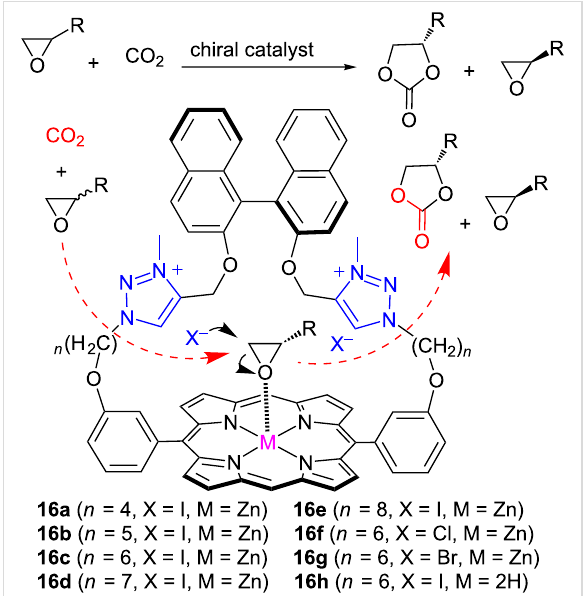
Figure 13: Chemical structure of compound 16 for the kinetic resolu- tion of epoxides.